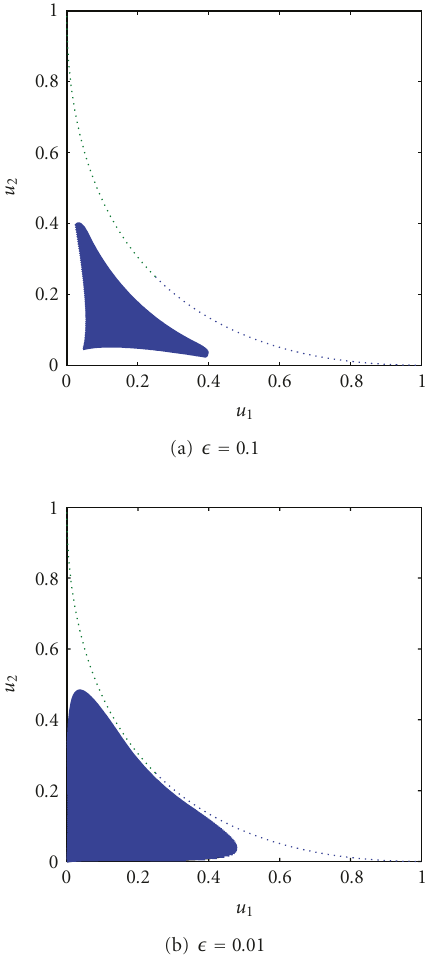
Figure 3: Payo ff s that can be achieved by the manager with quantized observation. (a) m = 5. (b) m = 15.